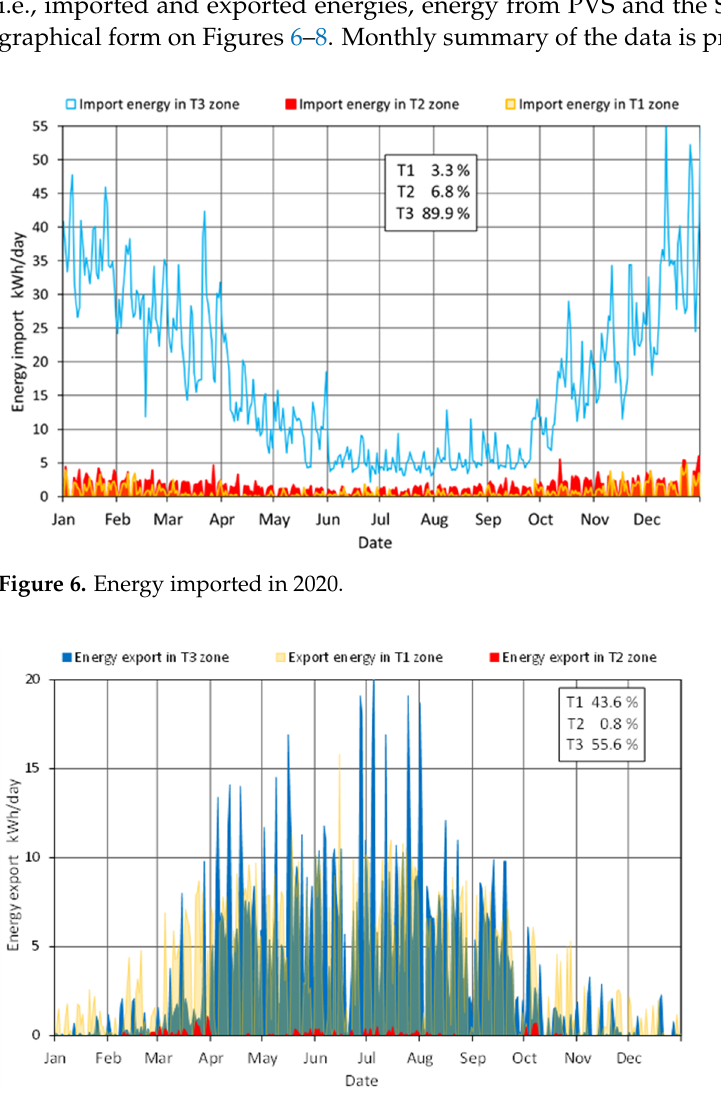
Figure 7. Energy exported in 2020. In the winter months, the amount of energy exported to the grid is lower than that taken from the grid in each of the T1 and T2 time zones. In order not to consume energy in zones T1 and T2, the missing energy will have to be replenished from the grid in the T3 zone, charging the batteries